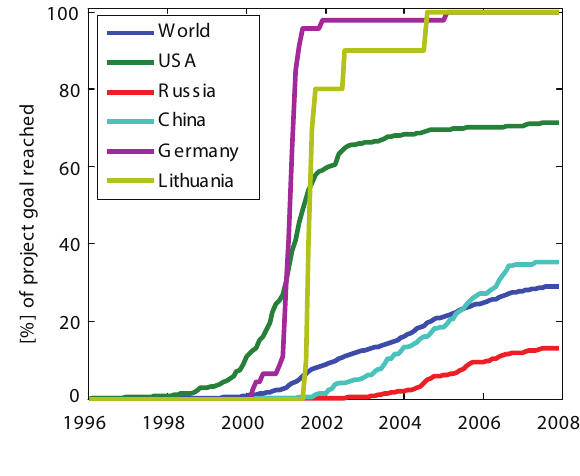
Fig. 8. Fraction of visited confluences in some selected countries